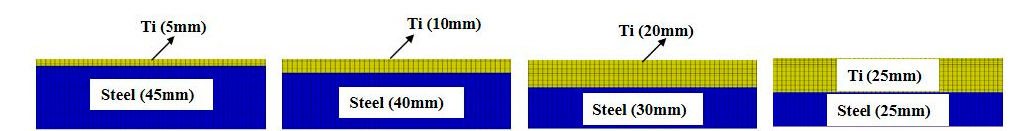
Figure 3. FE meshing of Ti/Steel bimetal clad plates with layers of different thickness.